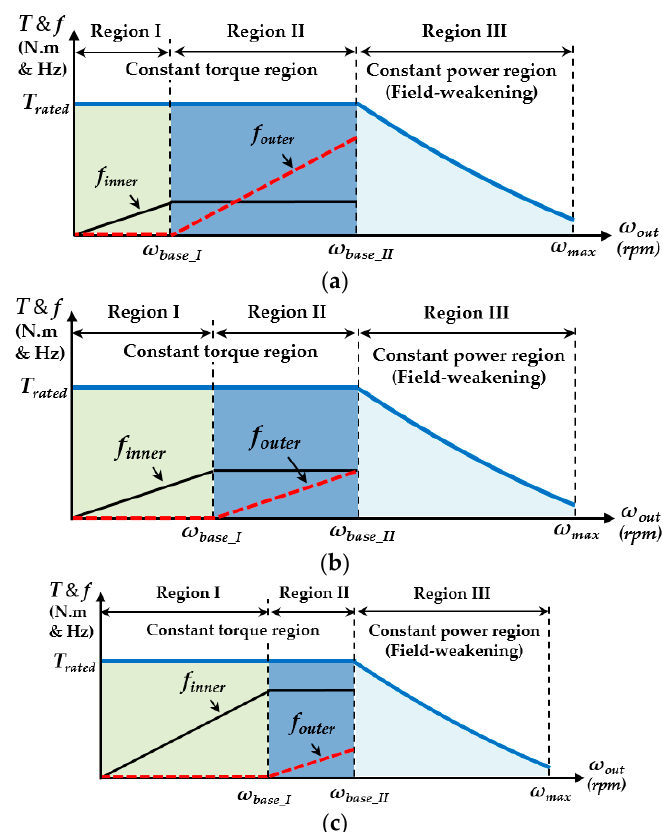
Figure 2. Division of the operating region according to the rated frequencies of the inner and outer windings. ( a ) Type I ( f inner 180 Hz and f outer 360 Hz); ( b ) Type II ( f inner 270 Hz and f outer 270 Hz); ( c ) Type III ( f inner 360 Hz and f outer 180 Hz). Table 1. Specifications of the analysis model.